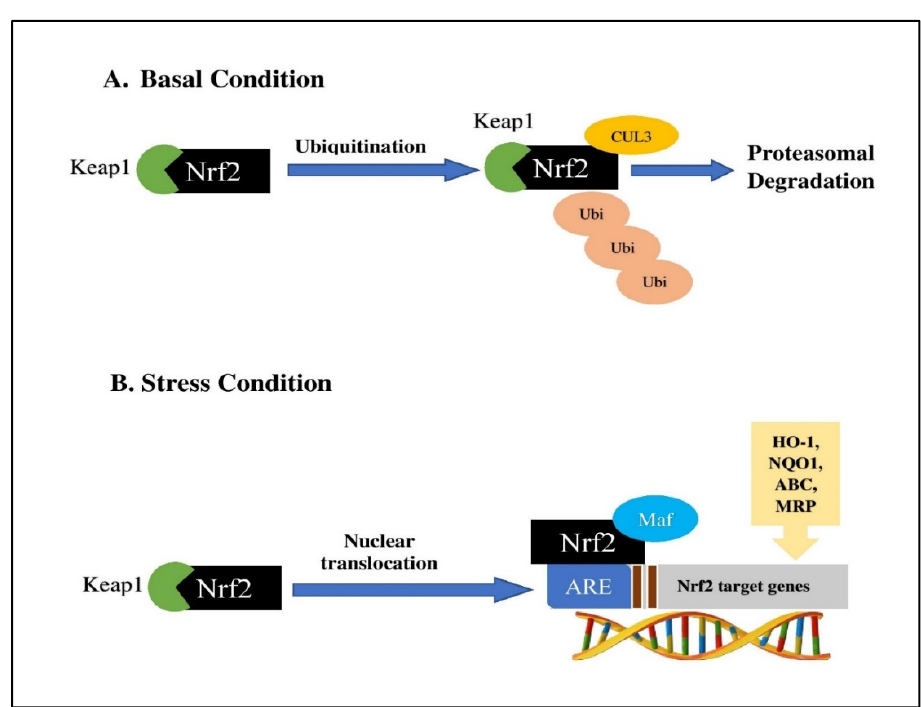
Figure 3. The basic Keap1-Nrf2-ARE signaling system. ( A ) Hydrolyzation of Nrf2 under basal conditions by ubiquitination. ( B ) Breakdown of Keap1-Nrf2 complex under stress conditions and nuclear translocation of Nrf2.